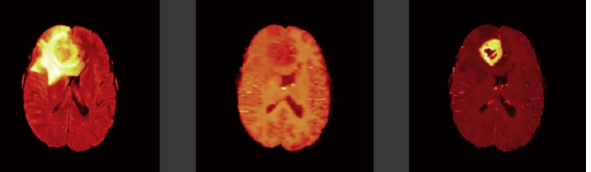
Figure 1. Brain tumor modalities. (Left image: FLAIR, Middle image: T1-weighted, and Right image: T1ce respectively).